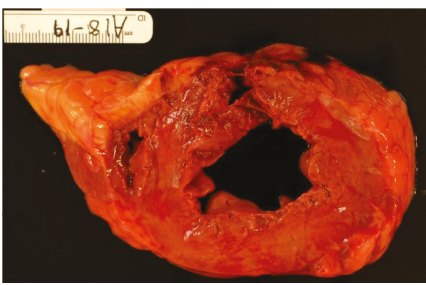
Figure 3: Gross pathology. A cut section of the left ventricle showing an anteriorly located, transmural slit-like rupture ( 1cm × 0 8 cm ) of the ventricular